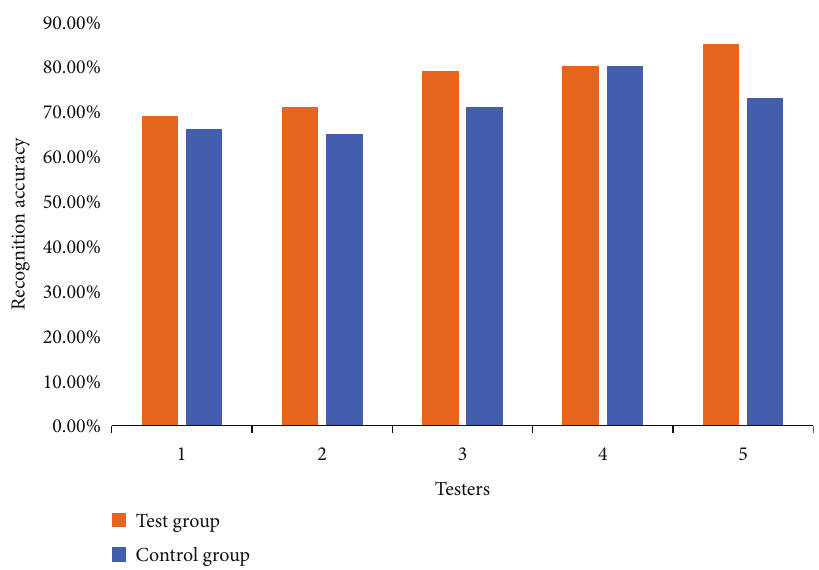
Figure 7: Facial recognition under the condition of high degree of face